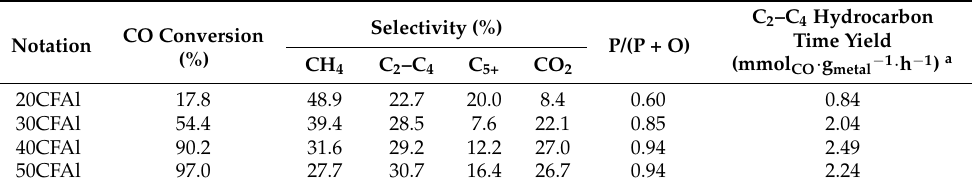
Figure 4. CO conversion and product selectivity of the CFAl catalysts. Table 2. Summary of the catalytic performances of the CFAl Catalysts.